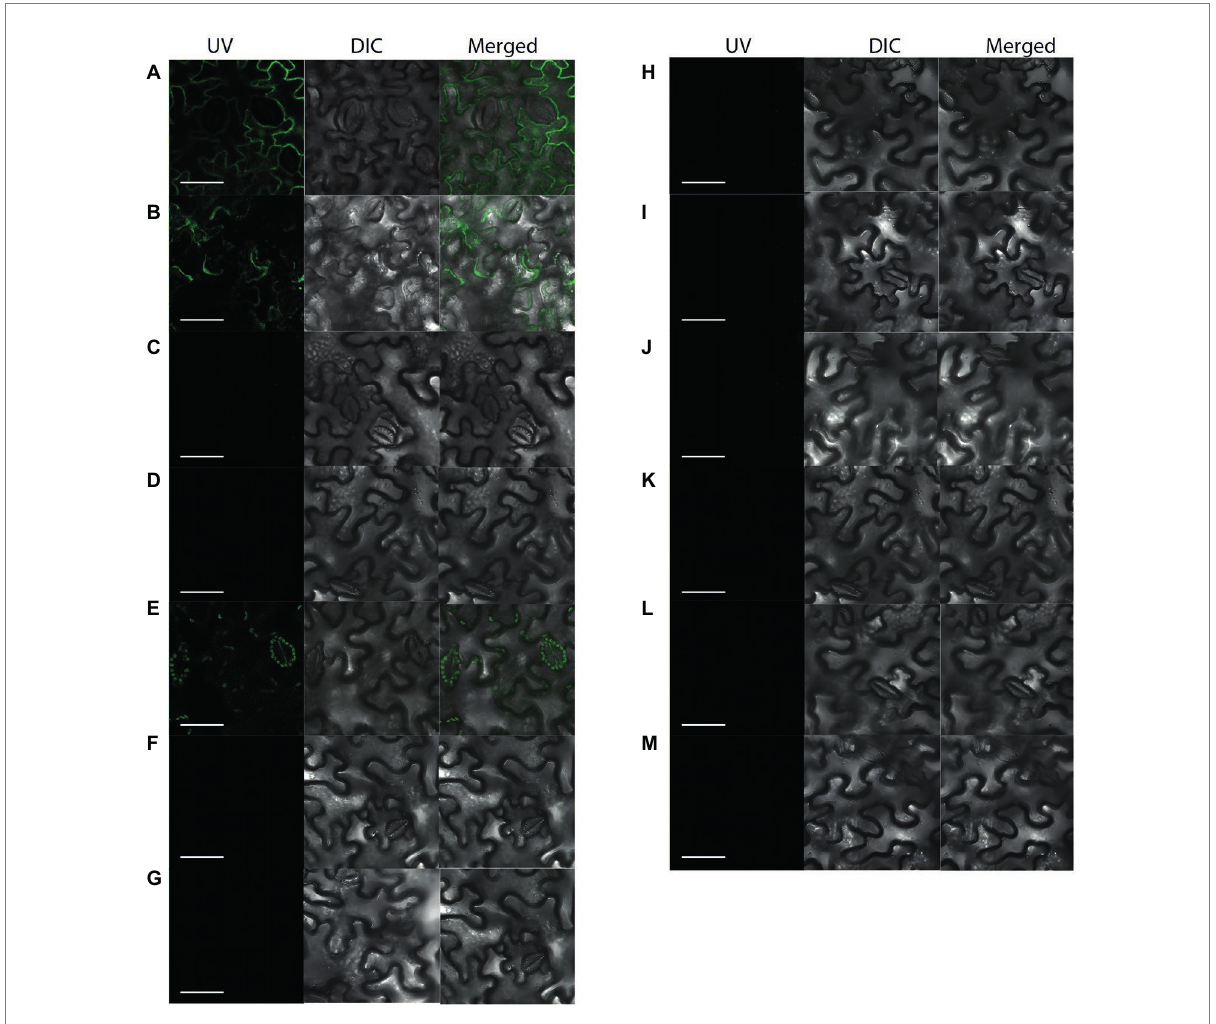
FIGURE 3 Fluorescent laser confocal detection of Nicotiana benthamiana epidermal cells. (A) pSPYNE(R)173- bZIP63 + pSPYCE(M)- bZIP1 ; (B) pSPYNE(R)173- ApCtf1 β + pSPYCE(M)- BDUbc ; (C) pSPYNE(R)173- ApCtf1 β + pSPYCE(M)- BDNADP-ME ; (D) pSPYNE(R)173- ApCtf1 β + pSPYCE(M)- BDWGA-3 ; (E) pSPYNE(R)173- ApCtf1 β + pSPYCE(M)- BDSKL1 ; (F) pSPYNE(R)173- ApCtf1 β + pSPYCE(M)- BDGolS2 ; (G) pSPYNE(R)173 + pSPYCE(M); (H) pSPYNE(R)173- ApCtf1 β + pSPYCE(M); (I) pSPYNE(R)173 + pSPYCE(M)- BDUbc ; (J) pSPYNE(R)173 + pSPYCE(M)- BDNADP-ME ; (K) pSPYNE(R)173 + pSPYCE(M)- BDWGA-3 ; (L) pSPYNE(R)173 + pSPYCE(M) BDSKL1 ; (M) pSPYNE(R)173 + pSPYCE(M)- BDGolS2 ; (A) positive control; (B–F) experimental groups; (G–M) negative controls; UV, GFP fluorescence; DIC, bright field; and Merged, superimposition of GFP fluorescence and bright